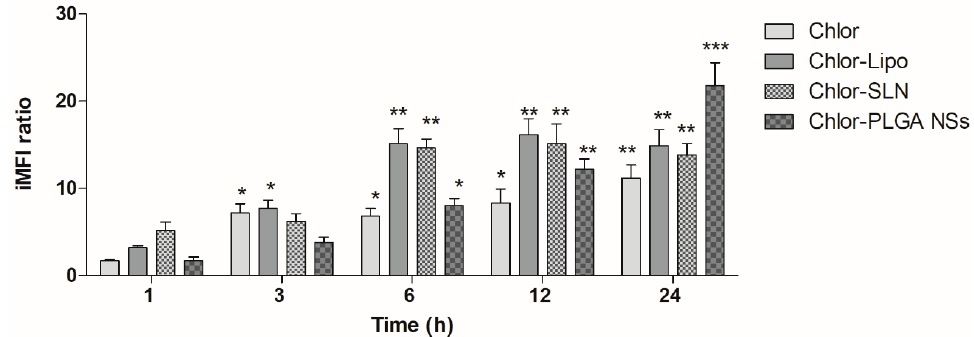
Figure 3. Chlor uptake by PC-3 cells. PC-3 cells were incubated with Chlor formulations at the same Chlor concentration (5 µM) for 1, 3, 6, 12 and 24 h. Fluorescent signal was detected using a flow cytometer at 488 nm excitation to measure the intracellular Chlor and expressed as the integrated mean fluorescence intensity (iMFI) ratio calculated as reported in Materials and Methods. Statistical significance vs. 1 h incubation: * p < 0.05; ** p < 0.01; *** p < 0.001.